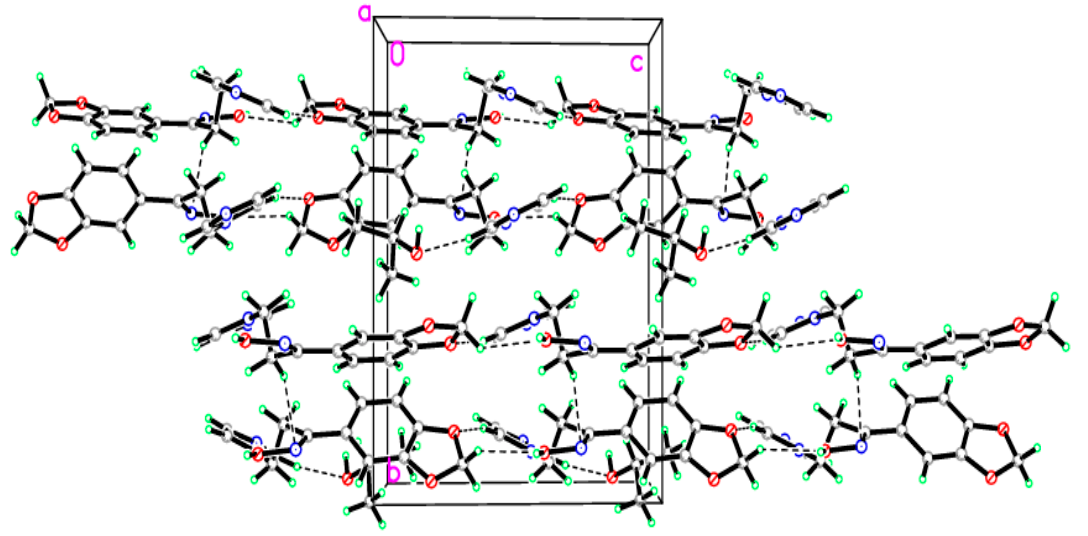
Figure 2. Crystal packing showing intermolecular hydrogen bonds as dashed lines along the b and c axes.